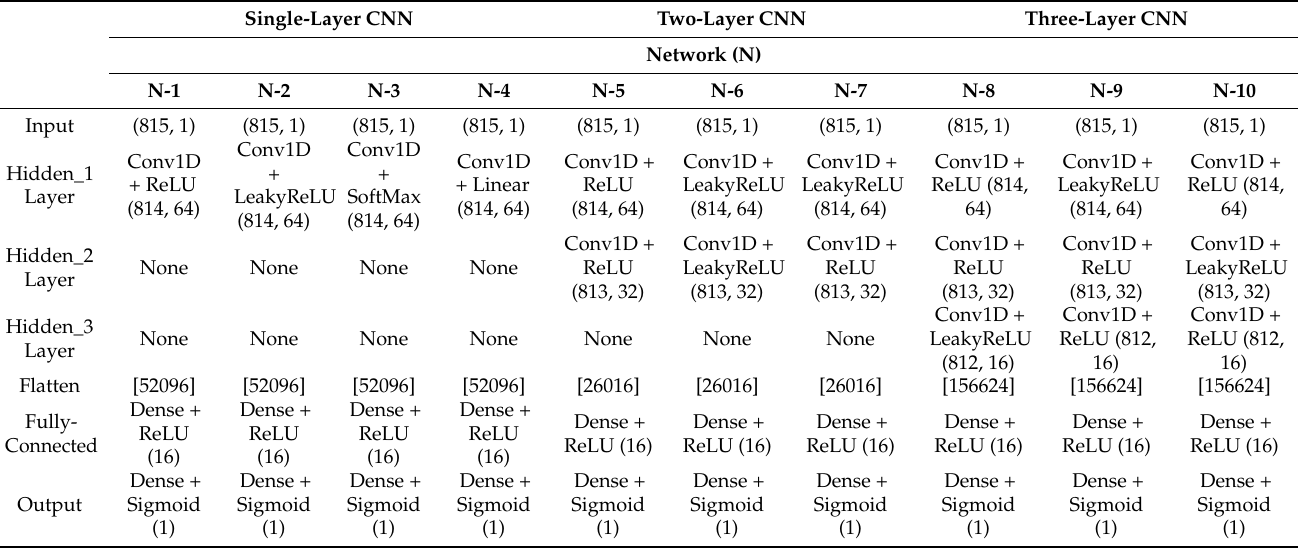
Table 1. Detailed CNN architecture for a single-lead ECG with one-convolutional, two-convolutional, and three-convolutional layers,